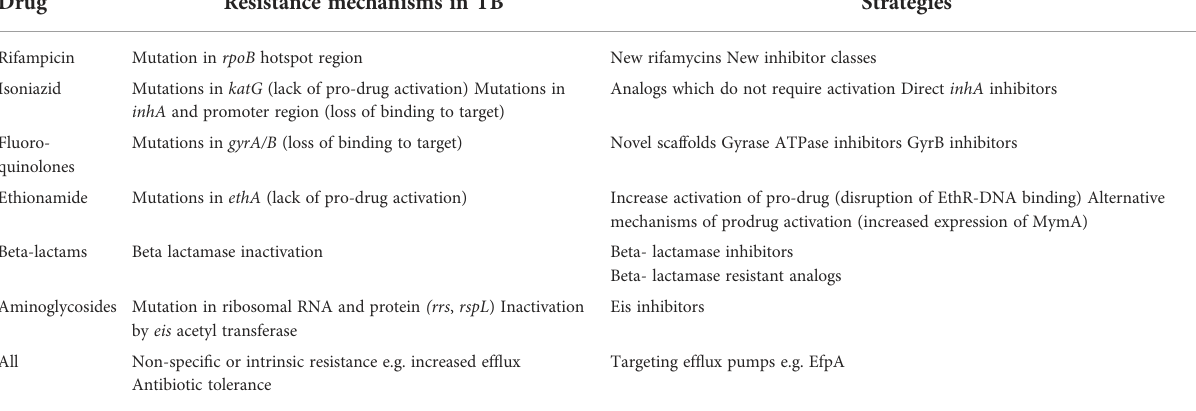
TABLE 1 Examples of resistance mechanisms to current TB drugs and approaches to overcome resistance (references in